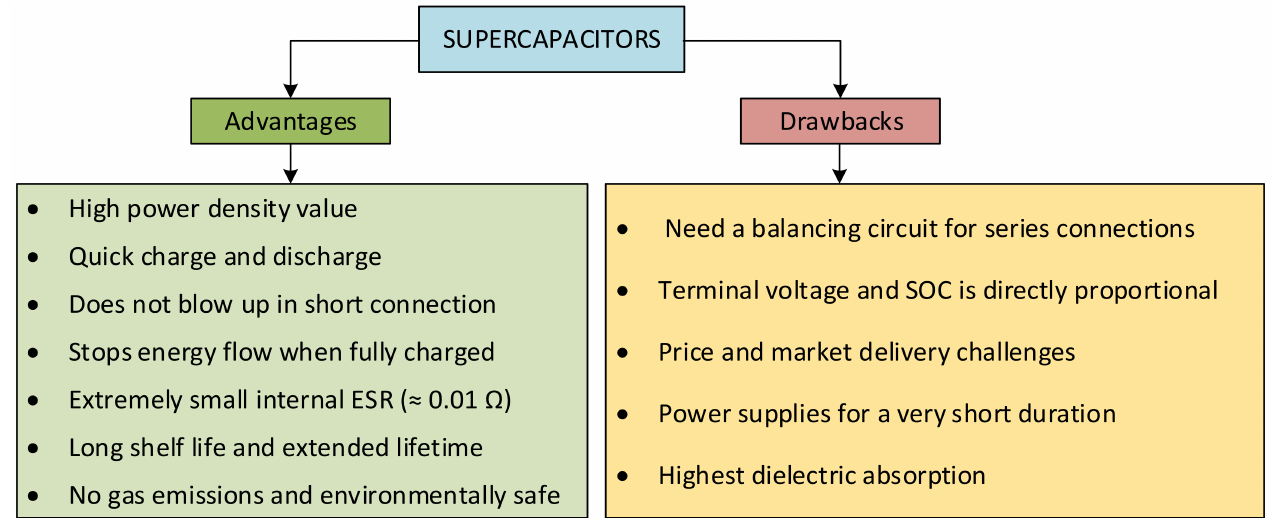
Figure 6. The main advantages and drawbacks of